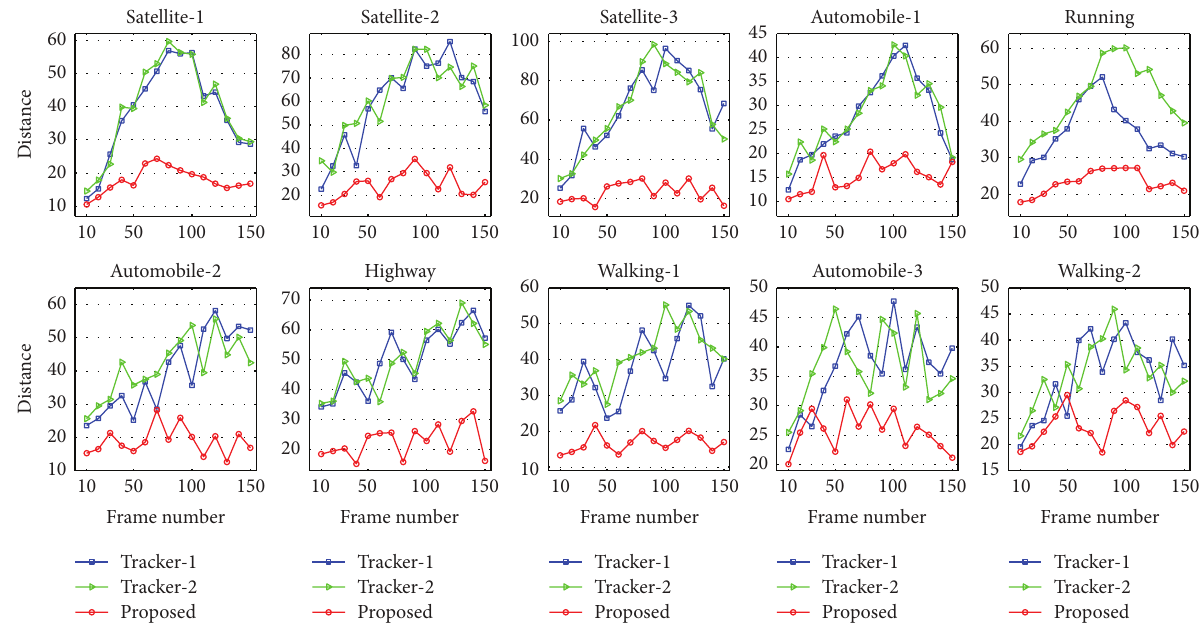
Figure 5: Euclidian distances between the tracked and artificially marked areas. Red curve: our proposed method; blue curve: Tracker-1 in [27]; green curve: Tracker-2 in [28].